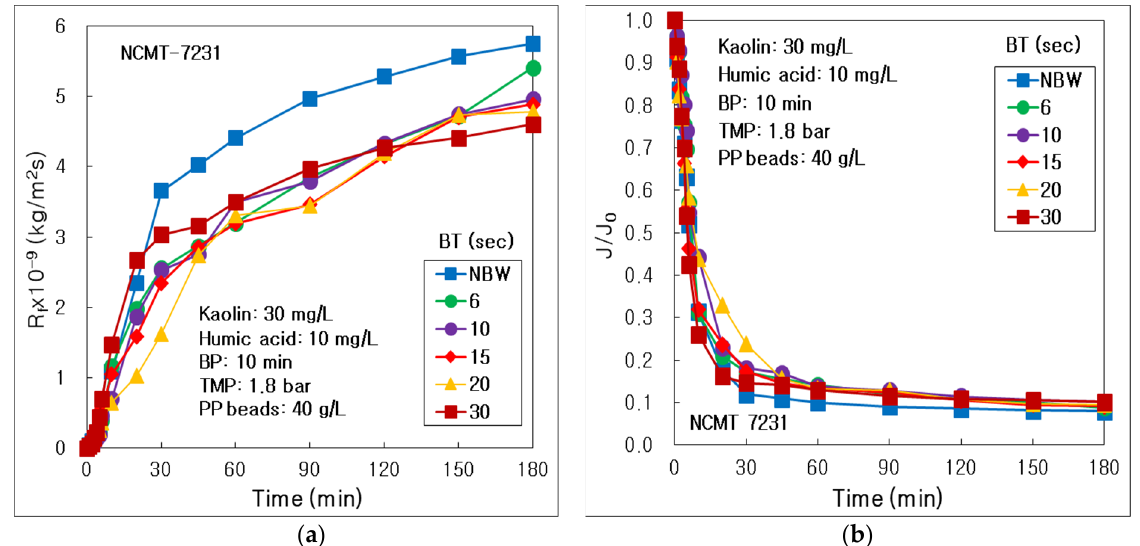
Figure 3. Influence of water backwashing time (BT) in the combined process of tubular alumina MF (NCMT-7231) and PP beads with UV irradiation and periodic water backwashing: ( a ) Resistance of membrane fouling; ( b ) Dimensionless permeate flux.